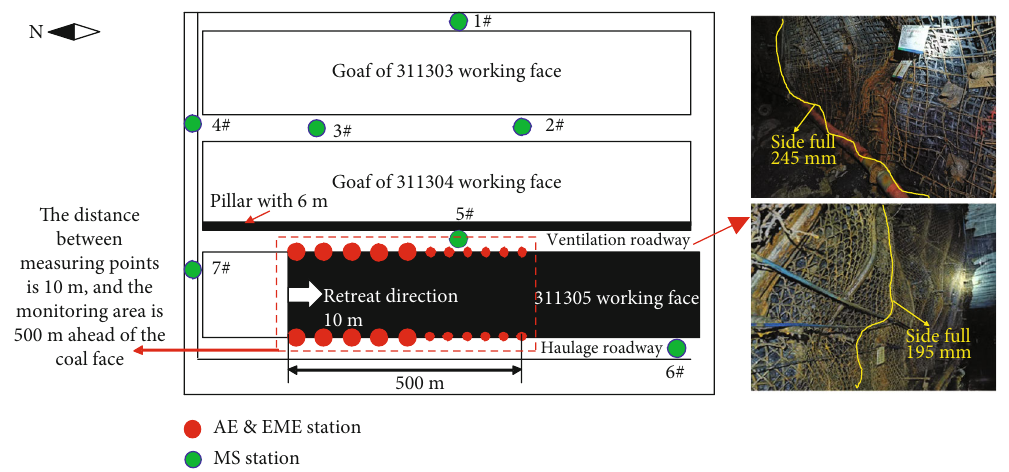
Figure 2: Position of the working face 311305 and layout of measuring